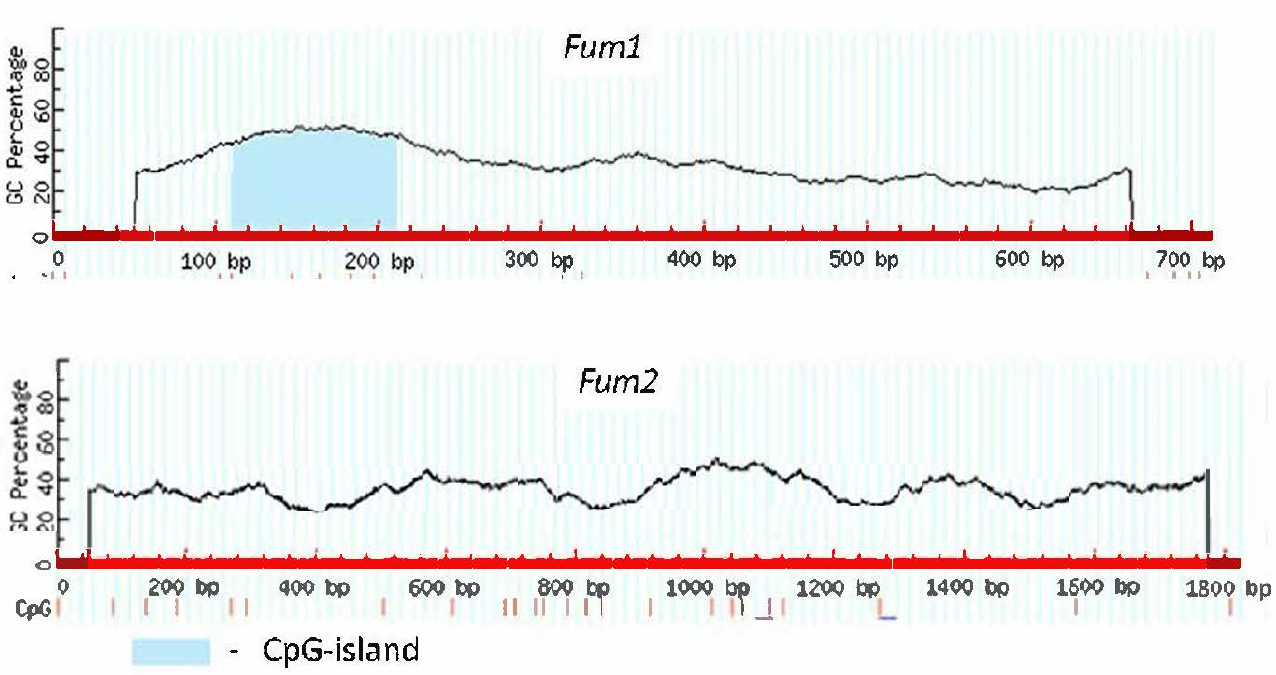
Figure 1. Analysis of CG dinucleotides in the promoters of the Fum1 and Fum2 genes from maize. The position of CG nucleotides is indicated by vertical lines.